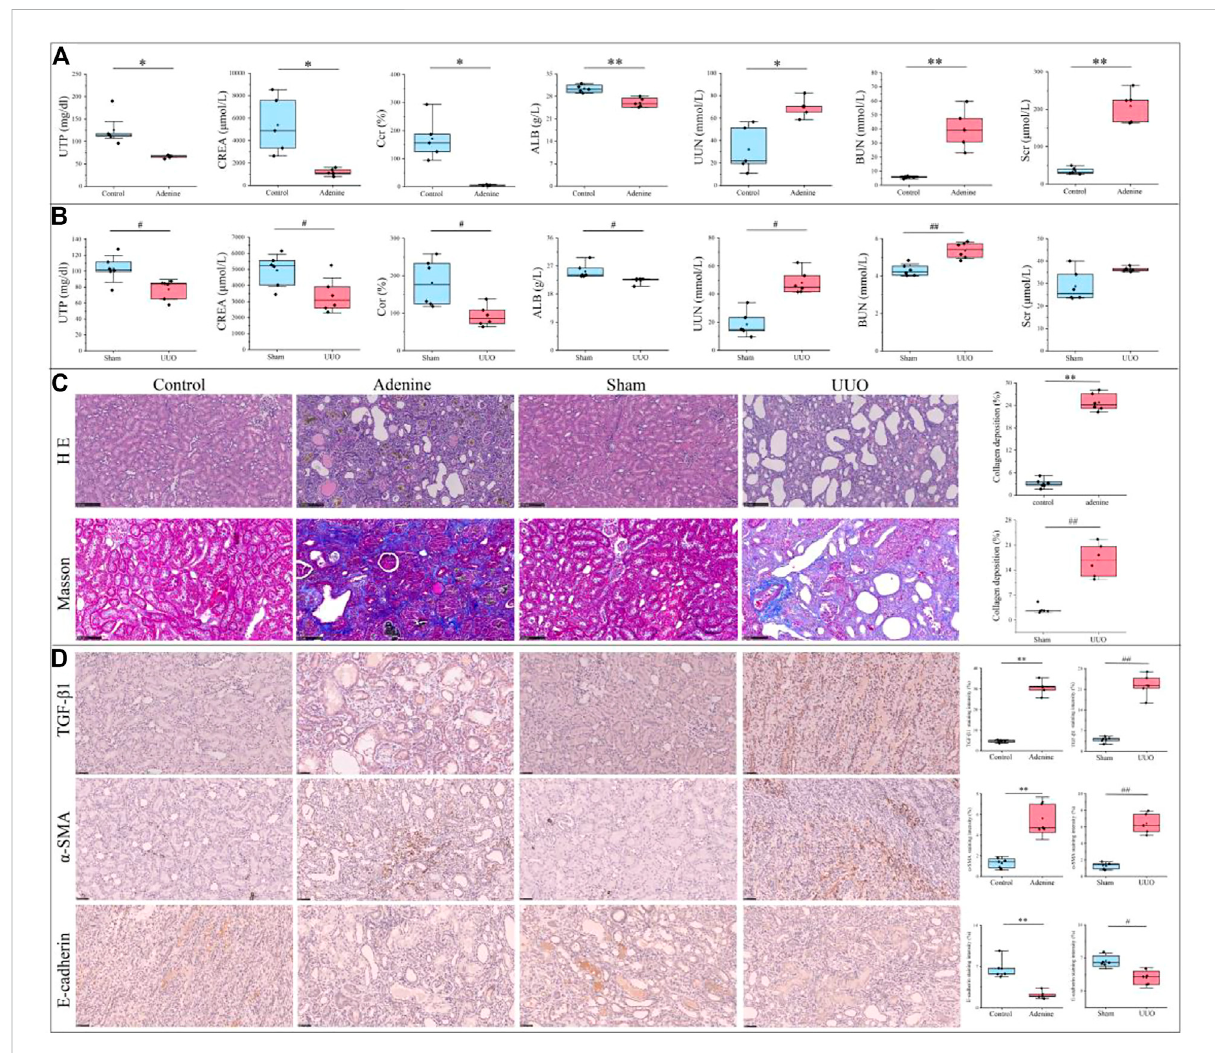
FIGURE 2 Renal function parameters, pathological characterization and immunohistochemical changes of RF-related adenine and UUO models. (A) Renal function parameters of rats in the control and adenine groups. (B) Renal function parameters of rats in the sham and UUO groups. (C) HE staining(200×),Masson staining(200×).and collagendepositioninthecontrol,adenine, sham,andUUOgroups. (D) Immunohistochemicalstaining (400×)andstainingintensityofTGF- β , α -SMA,andE-cadherininthecontrol,adenine,sham,andUUOgroups.Alldatashowedmean±SD,* p < 0.05 and ** p < 0.01 compared to the control group, # p < 0.05 and ## p < 0.01 compared to the sham